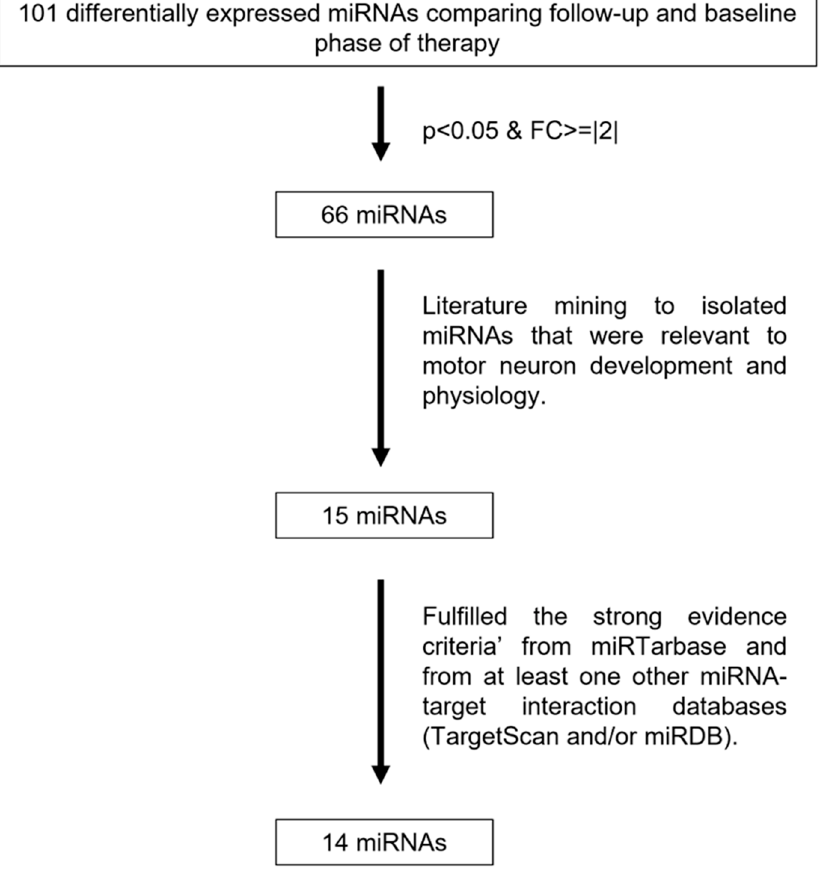
Figure 2. Flowchart depicting experimental approach for filtration of significant miRNAs in cere- brospinal fluid of children affected with spinal muscular atrophy for further exploration comparing follow-up and baseline phase of therapy.